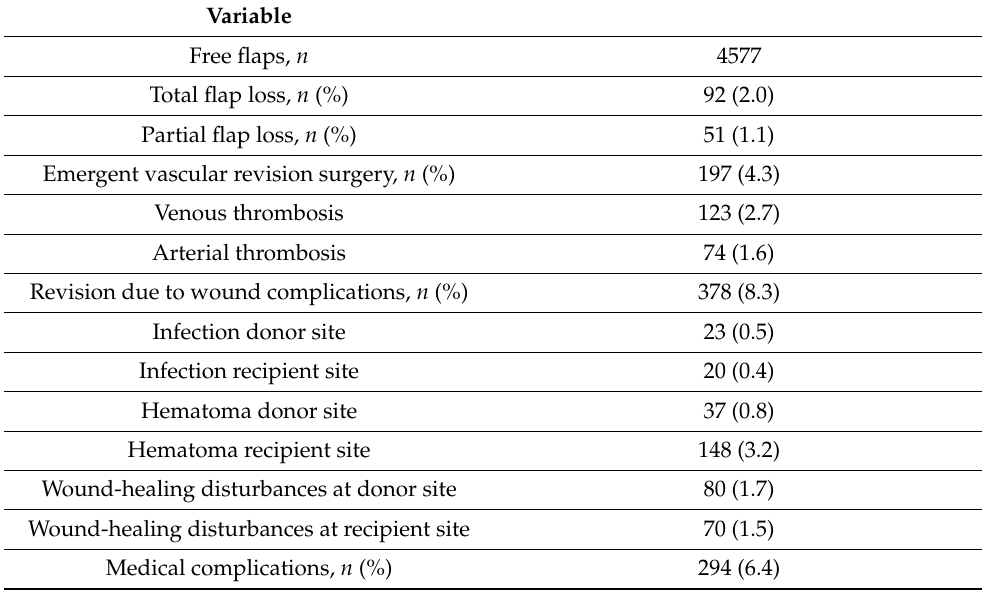
Table 4. Postoperative complications and free flap outcome over a follow-up period of three months. Percentages calculated based on the number of free flaps.